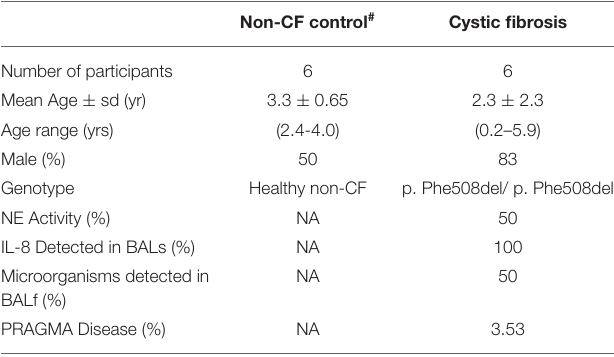
TABLE 2 | Patient demographics for subjects used for validation work including six non-CF children and six children with